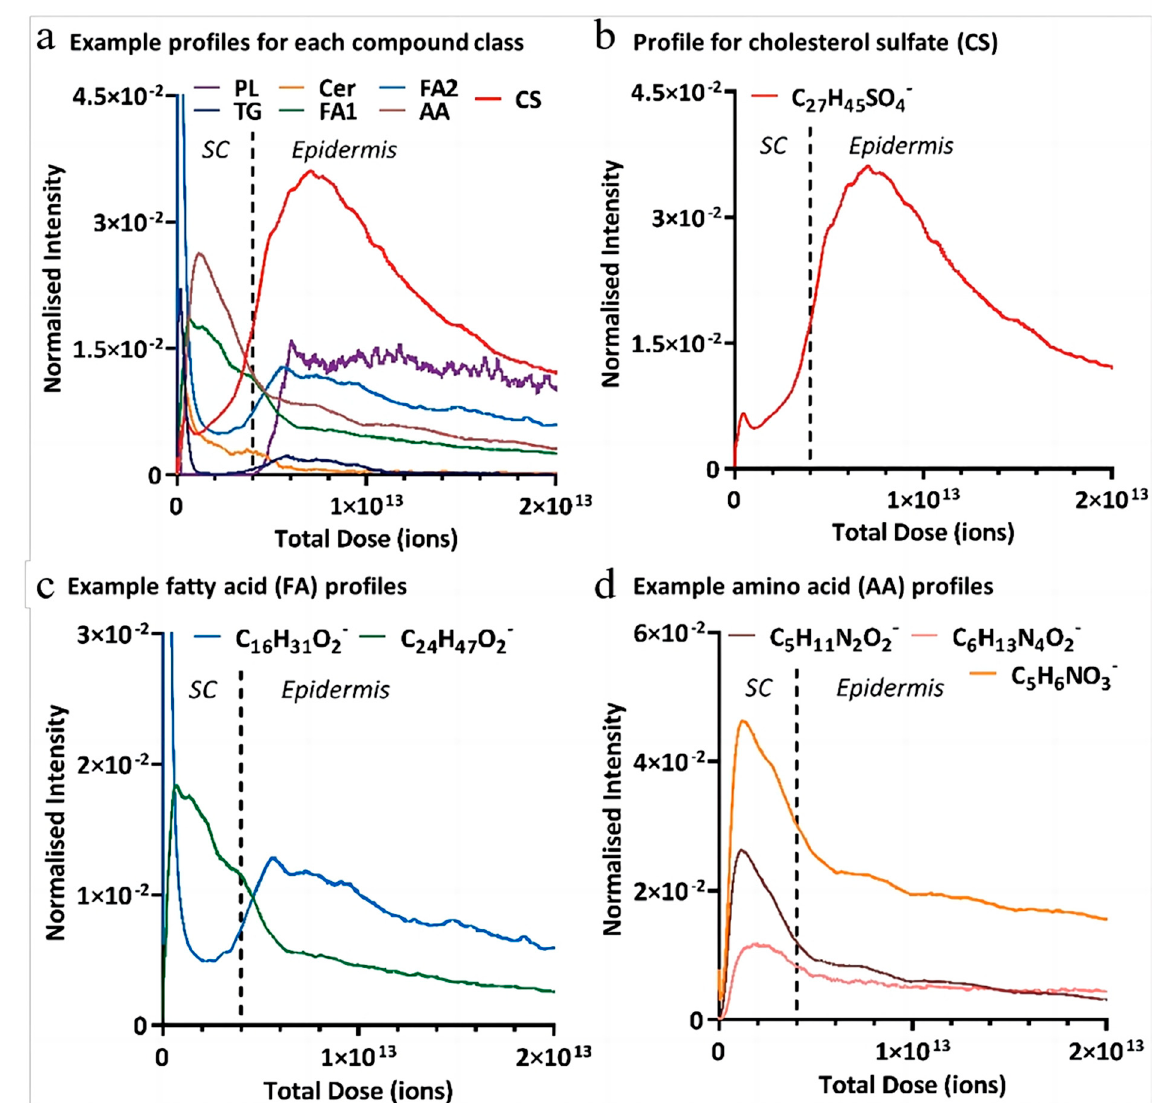
Figure 12. The 3D OrbiSIMS negative polarity depth profile data showing the ion intensity variation as a function of ion dose/skin depth for various putatively assigned compounds. ( a ) Examples of ions from each identified compound class are as follows: PL (phospholipids; C 41 H 77 NPO 8 ), TG (C 55 H 101 O 6 ), Cer (C 44 H 86 NO 5 ), FA1 and FA2 (FAs 1 and 2; C 27 H 47 O 2 and C 16 H 31 O 2 ), AA (amino acids; C 5 H 11 N 2 O 2 ), and CS (cholesterol sulfate; C 27 H 45 SO 4 ). ( b ) Cholesterol sulfate molecular ions (C 27 H 45 SO 4 ). ( c ) FAs, palmitic acid (C 16 H 31 O 2 ), and lignoceric acid (C 24 H 47 O 2 ). ( d ) NMF compounds, the amino acid arginine (C 6 H 13 N 4 O 2 ), and amino acid derivatives PCA (C 5 H 6 NO 3 ) and ornithine (C 5 H 11 N 2 O 2 ) [87]. Copyright 2022 National Academy of Sciences.